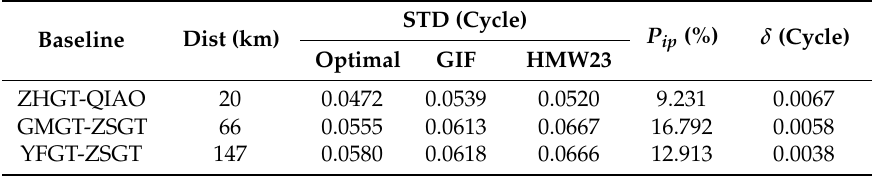
Table 5. Performance comparison for all IGSO and MEO satellites among the optimal , the GIF , and the HMW 23 combinations.